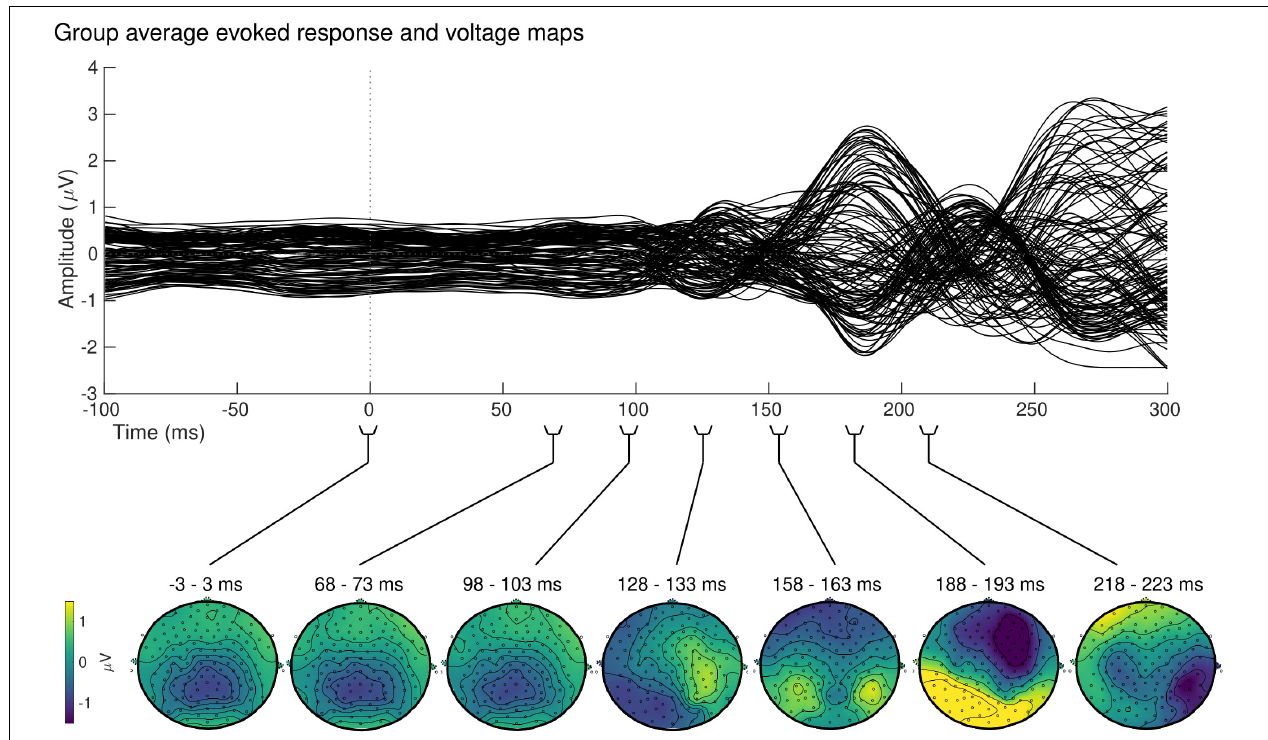
FIGURE 7 | Group sensor space results. Grand-average evoked response (top) and corresponding voltage topographic maps (bottom) after left visual field stimulation. Topographic maps are shown on a flattened electrode layout with anterior regions at the top and posterior regions at the bottom. Time 0 ms identifies the onset of the stimulus presentation. Positive amplitudes (yellow) were observed in the hemisphere contralateral to the stimulus presentation between 115 and 134 ms, followed by a bilateral positivity starting at approximately 153